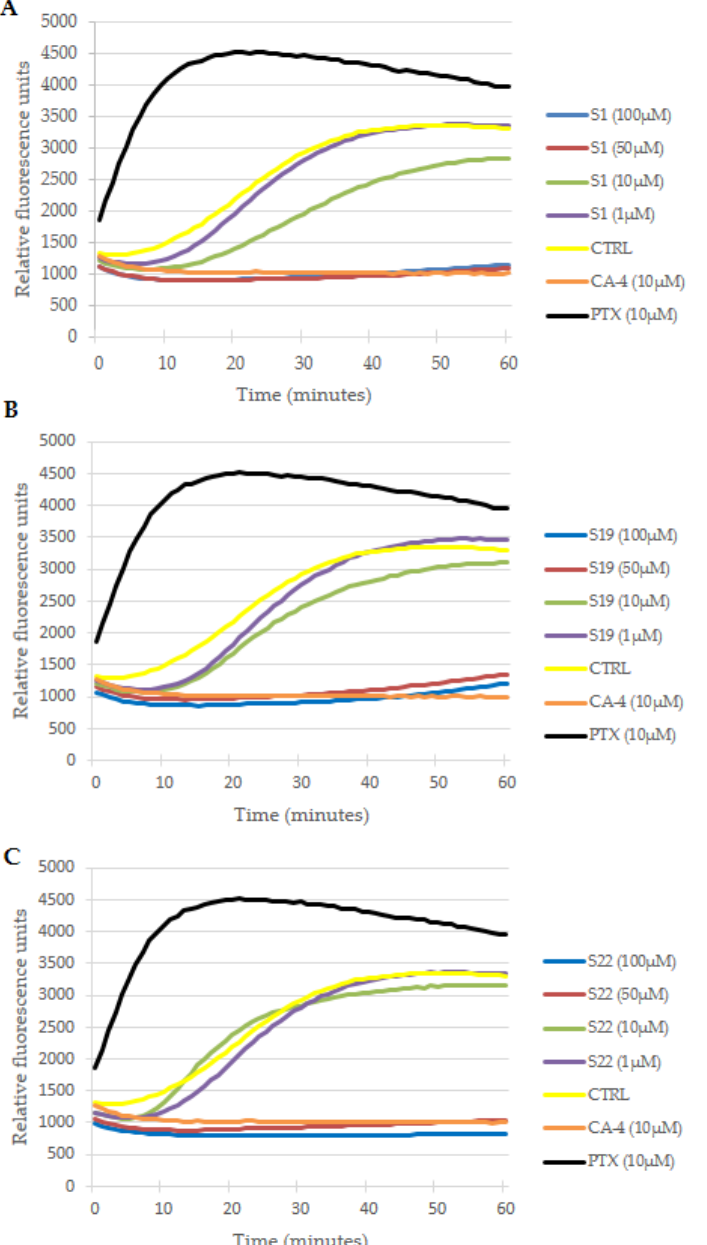
Figure 7. Effects of S1 ( A ), S19 ( B ) and S22 ( C ) derivatives on tubulin polymerization in cell free conditions. Increasing relative fluorescence units is indicative of tubulin polymerization. Paclitaxel (PTX) and combretastatin (CA-4) were used as references and DMSO (0.2%) as a vehicle control. Curves of tested compounds represent the mean from at least three independent experiments. Error bars are not shown for the sake of clarity.